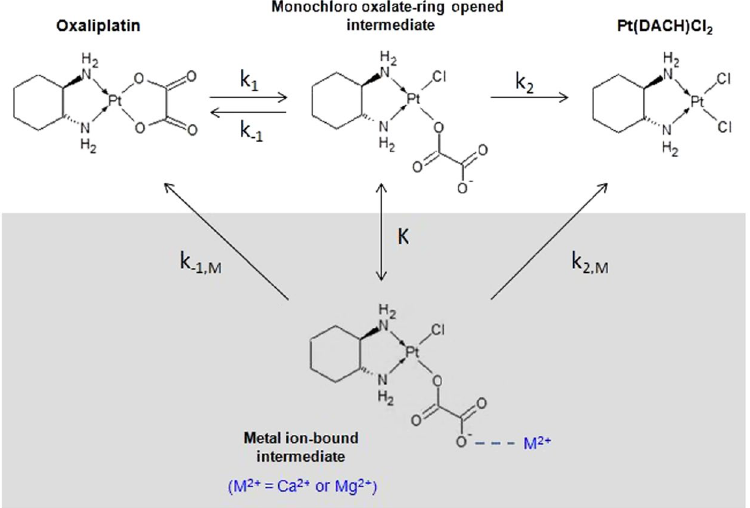
Figure 1. Reaction scheme of oxaliplatin degradation in chloride containing solution and chemical structures of intact oxaliplatin and its degradation products. A proposed additional reaction in CaCl 2 and MgCl 2 is shown in the shaded area. K, k: rate constants. M: